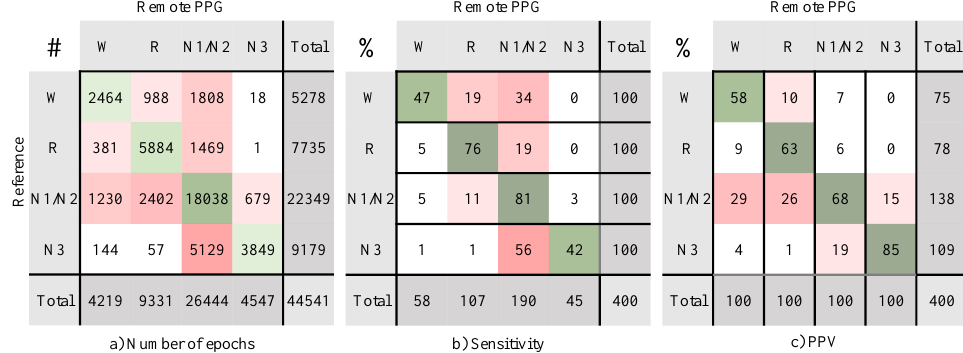
Figure A1. Confusion matrices for remote PPG versus reference PSG. ( a ) number of epochs, with a total of 30,235 (68%) correctly classified (diagonal, in green); ( b ) sensitivity, relative to ground truth class; ( c ) PPV, Positive predictive value, relative to predicted